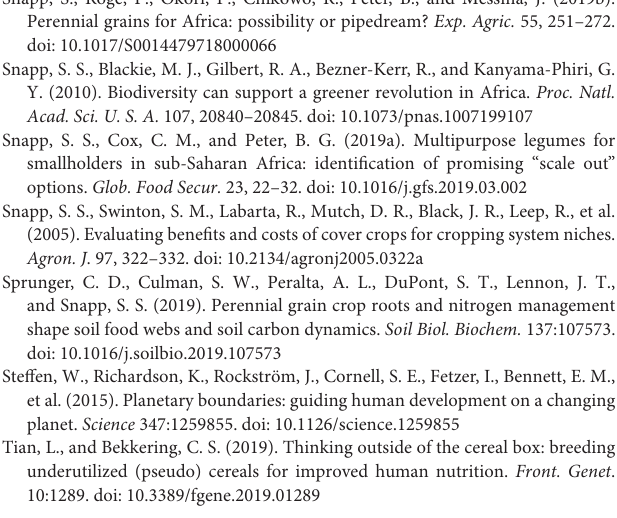
Yellow-Huai-Hai